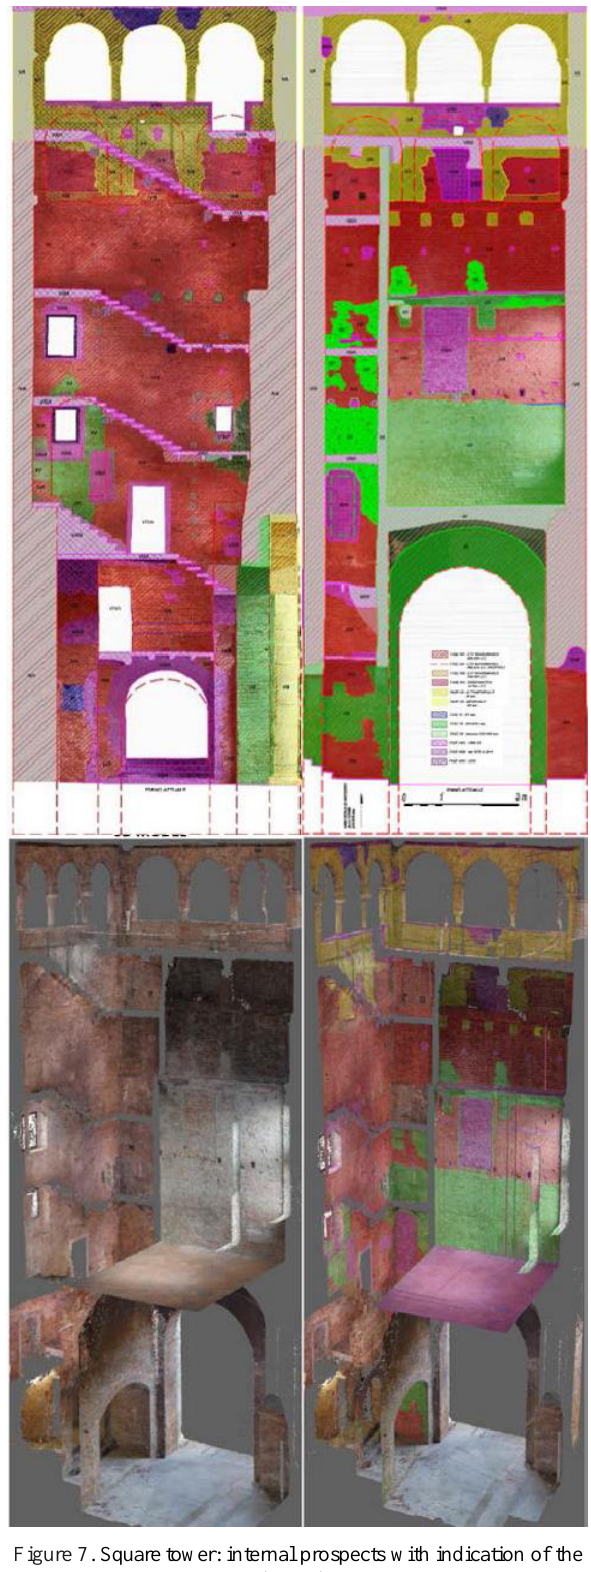
Figure 7. Square tower: internal prospects with indication of the phases on the orthophotos (above) and the stratigraphic phases projected on the 3D model (below) The historical evolution of the tower, mapped on the model, make possible to rebuild 3D representations of it in the different